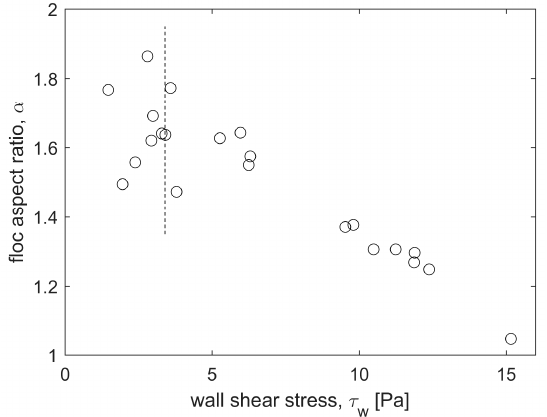
Figure 8. Floc aspect ratio (axial size/radial size) as a function of wall shear stress. The yield stress τ y = 3.4 Pa is shown with a vertical dashed line.